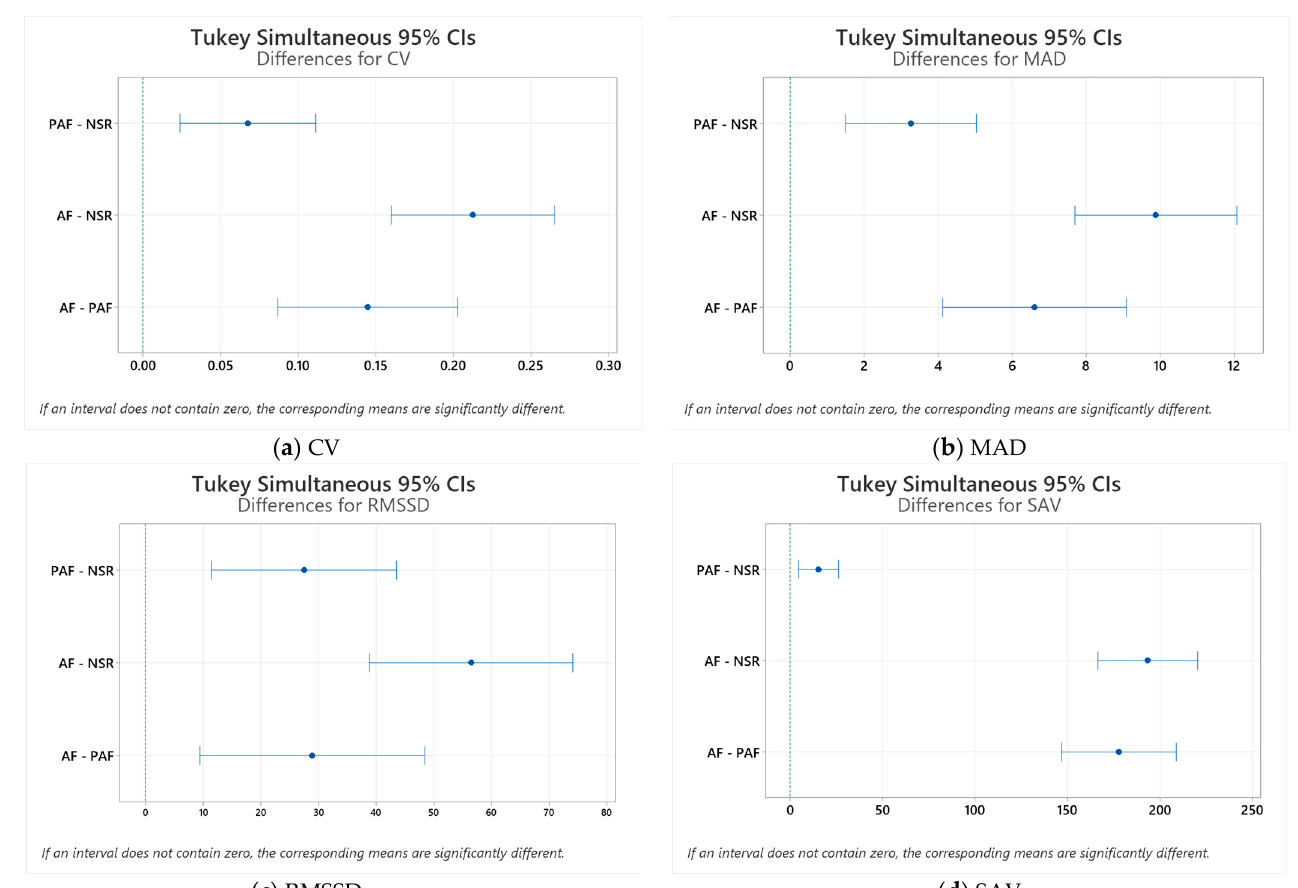
Figure 6. Tukey pairwise comparisons of variables, when numbers 1, 2, and 3 represent NSR, PAF, and AF,